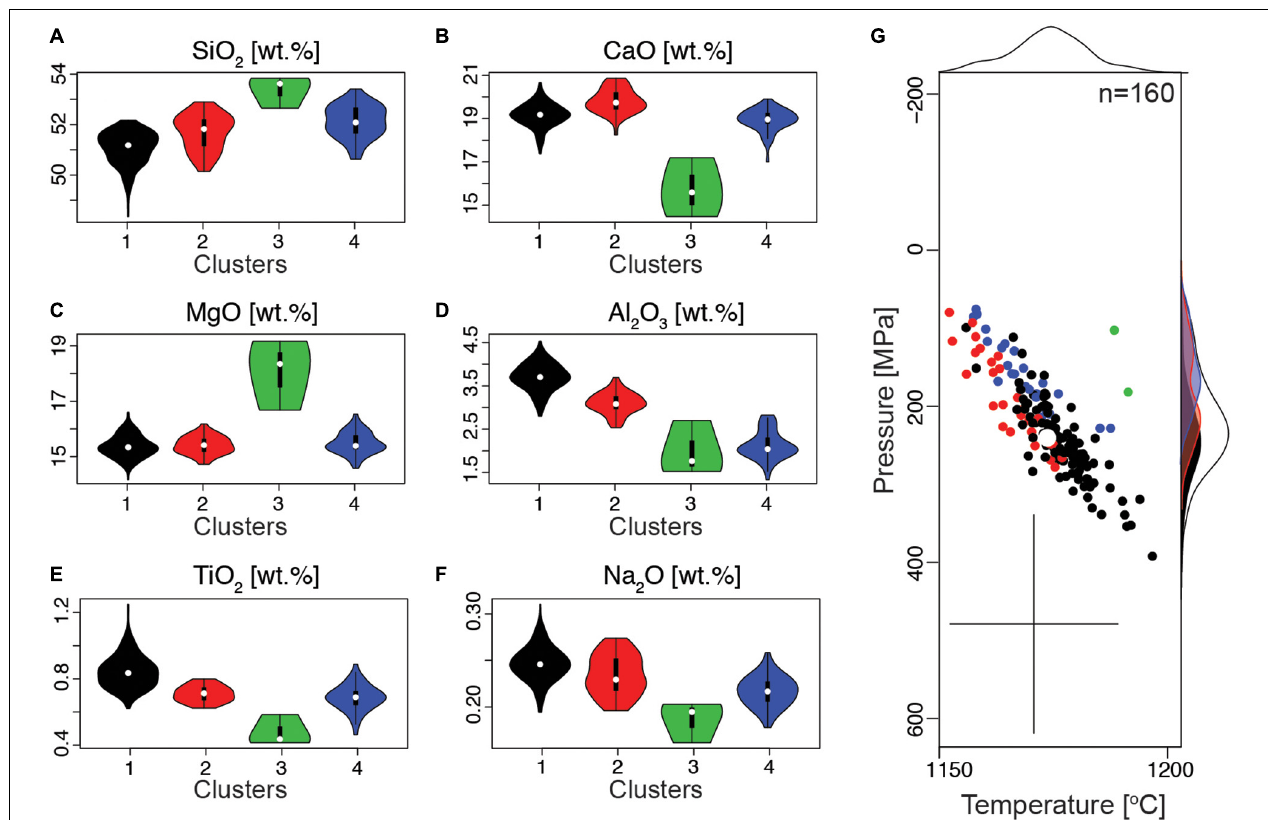
FIGURE 8 | Chemistry of cpx crystals and resulting thermo-barometry calculations. (A–F) Violin plots showing the density distribution of each of the oxides for all cpx analyses with color scheme as in Figure 4 . (G) Pressure and temperature for each analysis were calculated using the geobarometer of Neave and Putirka (2017) together with the thermometer (Eq. 33) of Putirka (2008). The white circle provides the average value of pressure and temperature obtained with this approach. The density plots on the side of the diagram show the distribution of pressure and temperature calculations. The cross indicate the error/uncertainty of